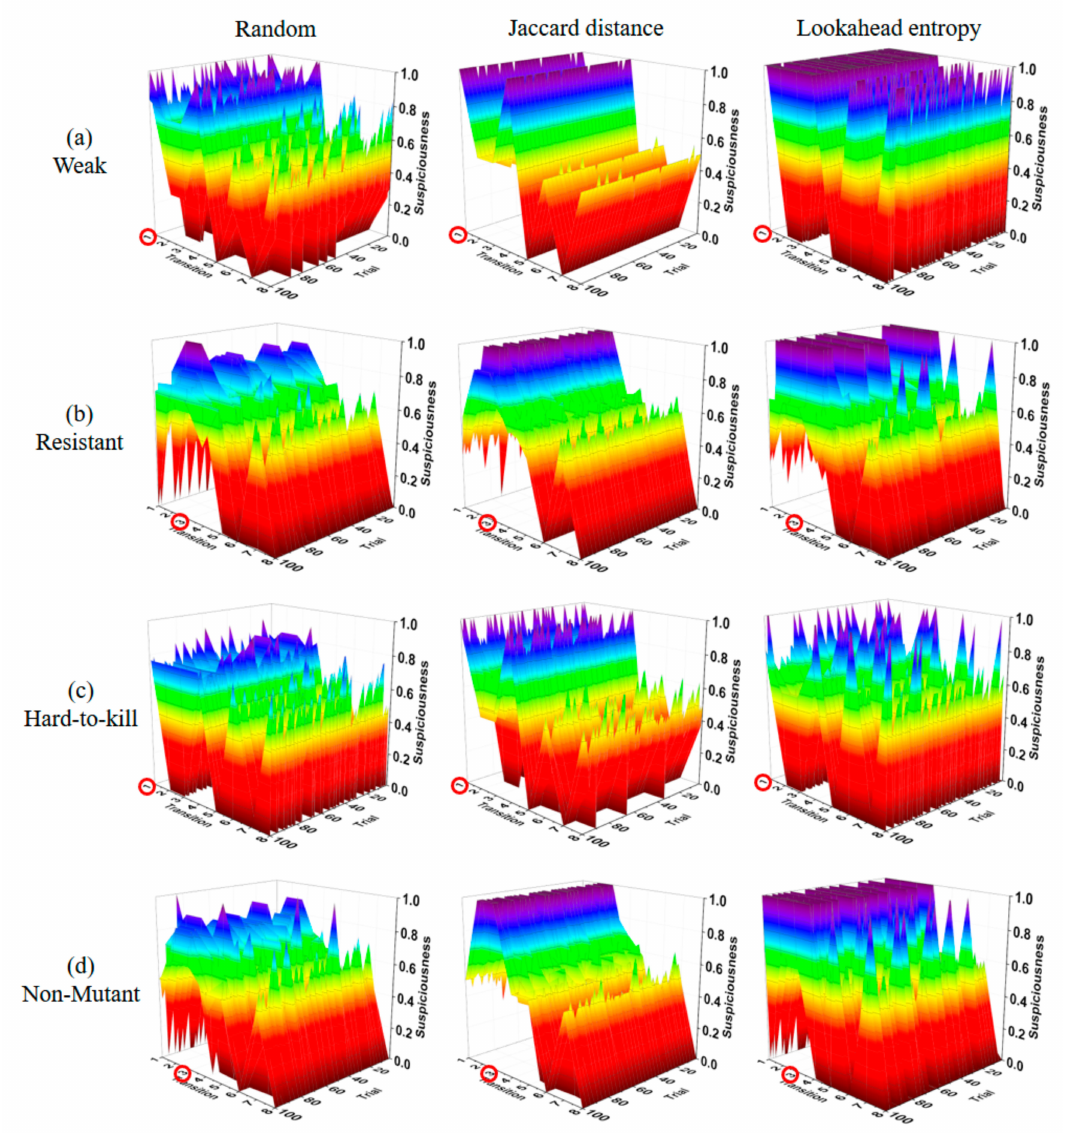
Figure 12. Suspiciousness of the whole transition (ring state